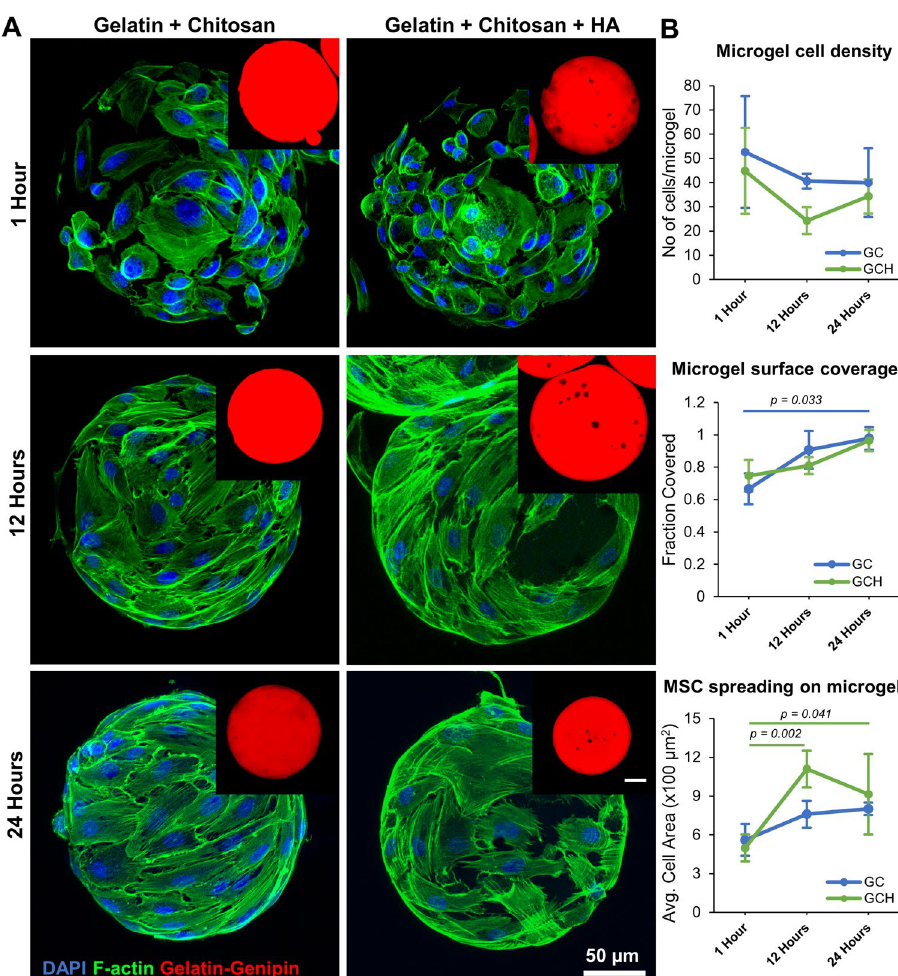
Figure 4. MSC seeded on osteogenic microgels. ( A ) Confocal stacks of microgels seeded with MSC at different timepoints. The cells are stained for cytoskeletal F-actin using phalloidin (green) and nuclei with DAPI (blue). The insets show the red fluorescence of the gelatin matrix crosslinked with genipin. ( B ) (top to bottom) the average number of MSC attached per microgel, the fraction of microgel surface covered by attached MSC, and the average area of the MSC attached to the microgel surface over time (n = 5). Bar chart legend: GC-Gelatin + 0.25% Chitosan, GCH-Gelatin + 0.25% Chitosan +